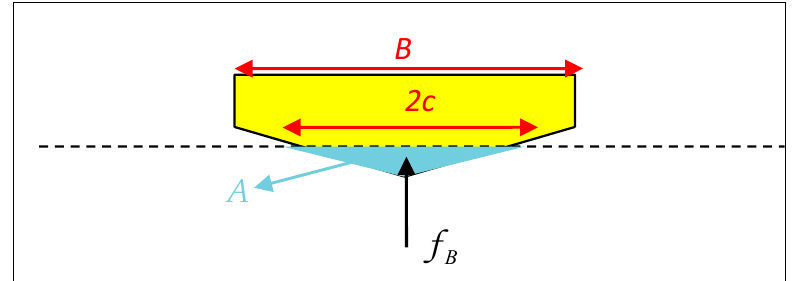
Figure 4. The hydrostatic force acting on the section.